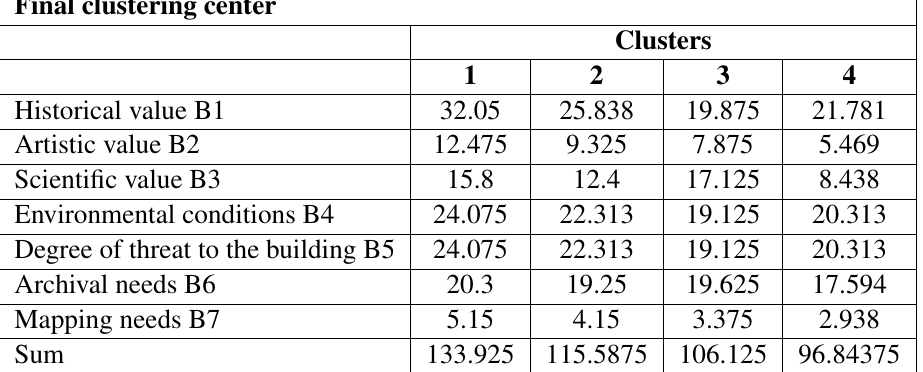
Table 1 Final clustering centre.